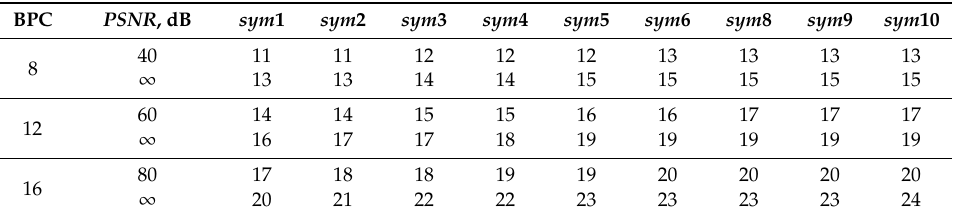
Table 11. Minimum values of r , at which the result of 3D medical images DWT with symlets reaches high and maximum quality.